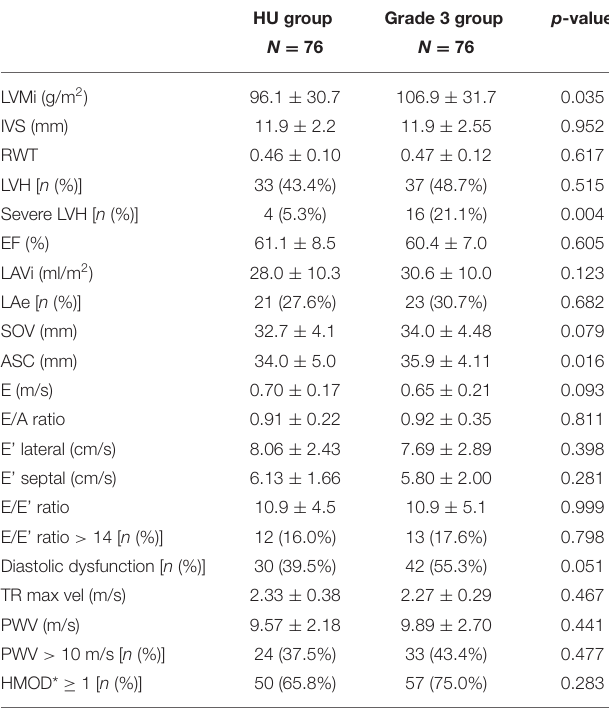
TABLE 2a | Comparison between the hypertensive urgencies (HU) group and Grade 3 group (demographic and clinical characteristics). HU group